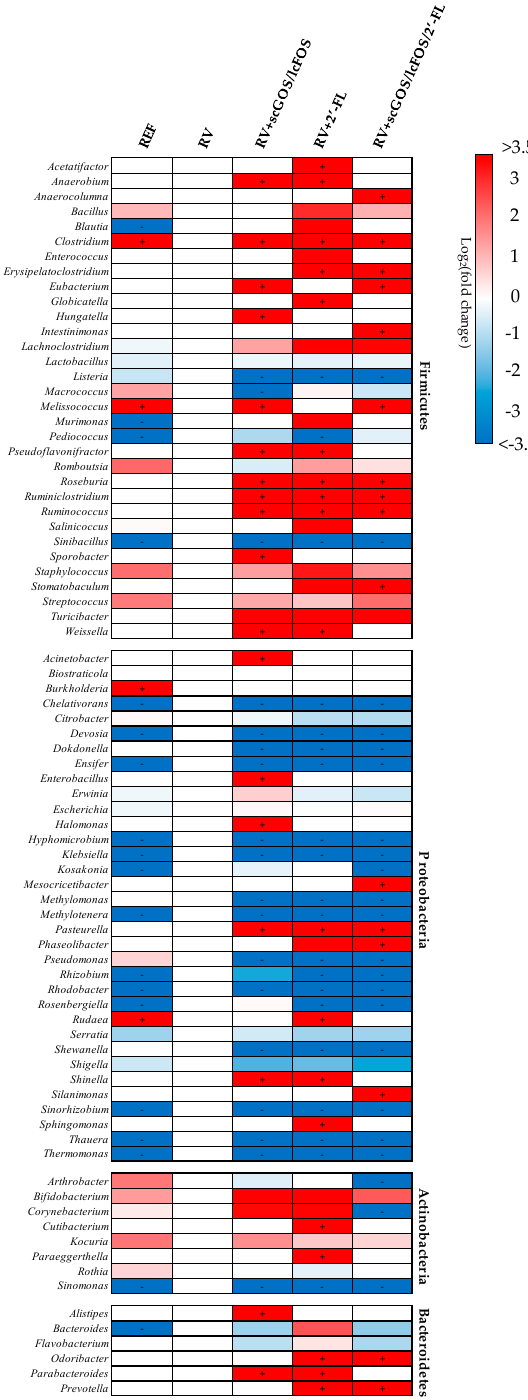
Figure 4. Summary of genera variation in fecal microbiota at the peak of diarrhea (day 8): A heat map of the mean relative abundances of the prominent OTUs assigned to the genus level is represented. The rows represent the genera and the columns the experimental groups. The log2 of the fold change with respect to the RV group was calculated and assigned a color following the legend. Genera which were present in a group but not in the RV group were assigned the maximum variation ( > 3.5, marked with a “ + ”), whereas the genera which were presented in the RV group and not in the other groups were assigned the minimum variation ( < − 3.5, marked with a “-“). The results are derived from n = 3 / group. VM: Verrucomicrobia .